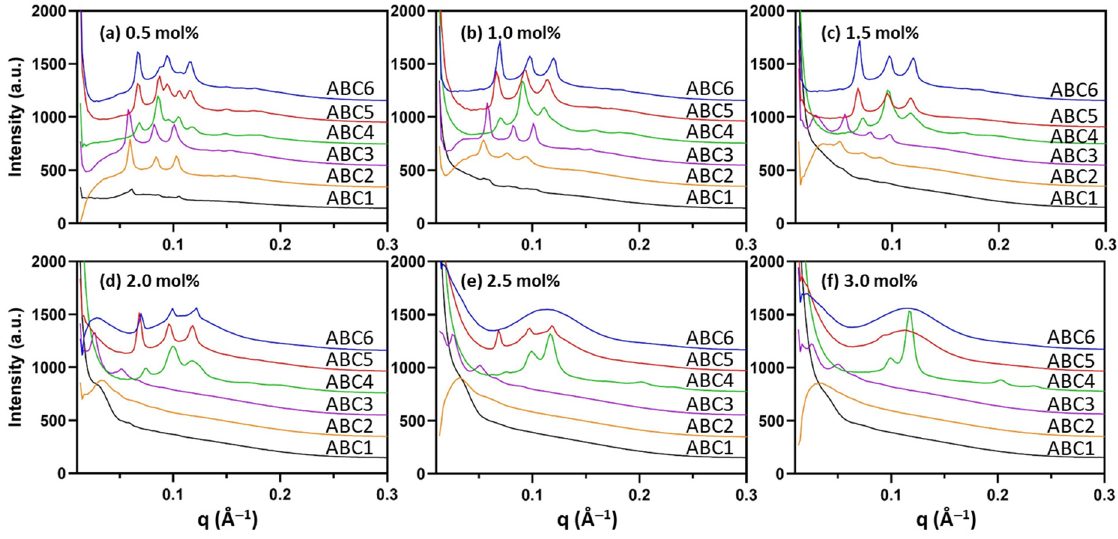
Figure 3. SAXS diffraction patterns of MO nanoparticles stabilized by the synthetic ABCs at ( a ) 0.5 mol%; ( b ) 1.0 mol%; ( c ) 1.5 mol%; ( d ) 2.0 mol%; ( e ) 2.5 mol%; ( f ) 3.0 mol% to the amount of MO. All measurements were performed at 25 ° C.